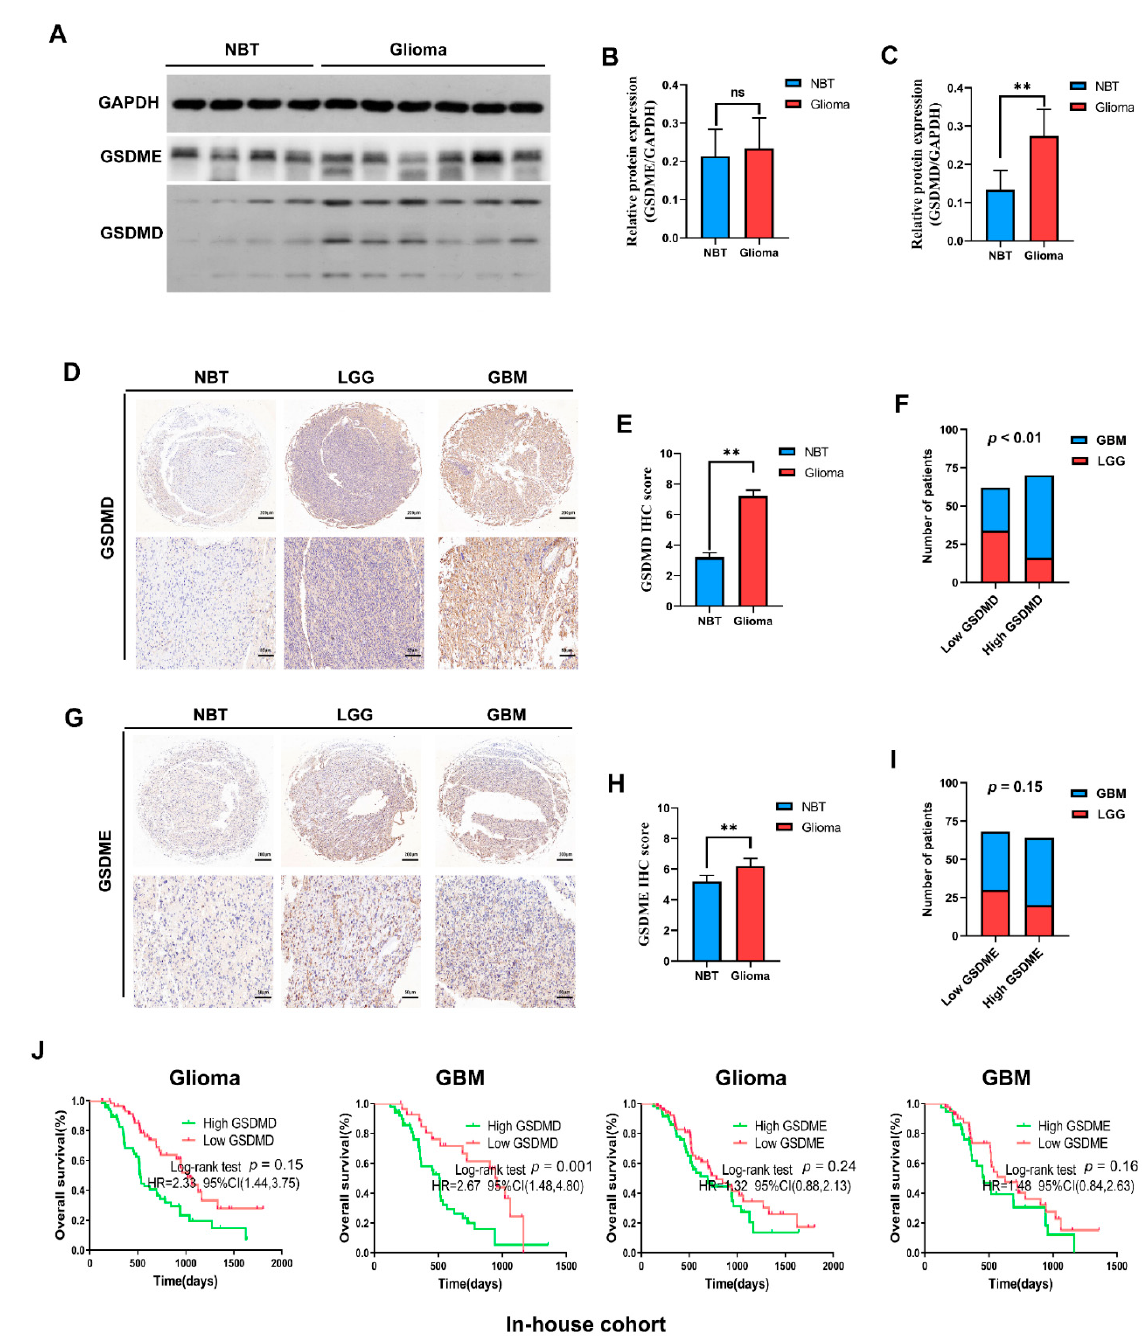
Figure 5. In-house cohort validation ( A – C ) Western blot detection of GSDMD and GSDME expression in glioma tissues and nontumor brain tissues (NBT). GAPDH was used as internal reference. ( D – F ) IHC staining of GSDMD in NBT, lower- grade glioma (LGG) and glioblastoma (GBM). ( G – I ) IHC staining of GSDMD in NBT, LGG and GBM. ( J ) Kaplan–Meier analysis was employed to assess the association between GSDMD/GSDME expression and the prognosis of glioma patients. ** p < 0.01. ns, no significance. HR, hazard ratio.